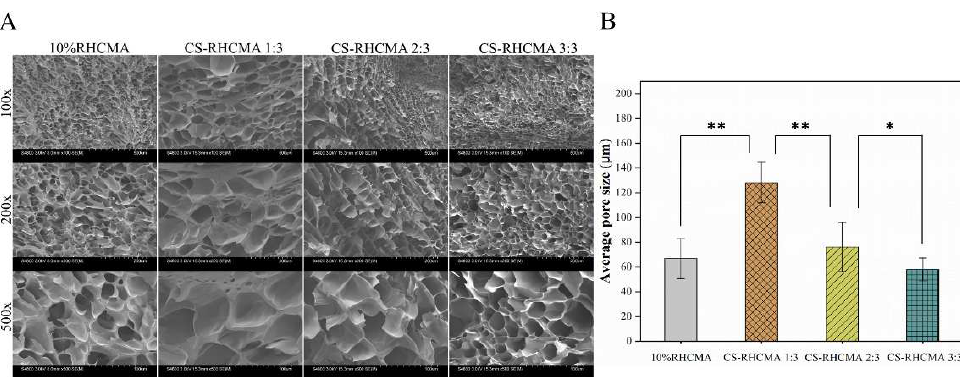
Figure 3. Internal morphology characterizations of the samples prepared from UV-cured bioinks. ( A ) SEM images of the internal morphology of the freeze-dried RHCMA and CS-RHCMA samples. Scale bar = 200 µ m. ( B ) The summarized average pore size of the freeze-dried RHCMA and CS- RHCMA samples. Significance is indicated with * p < 0.05 and ** p <